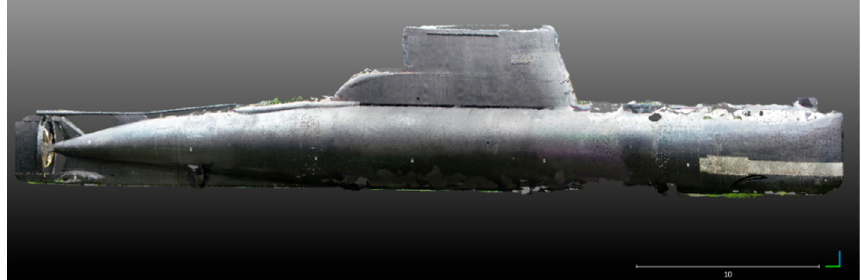
Figure 8. The object modelled with a photogrammetry technique (colored point cloud).